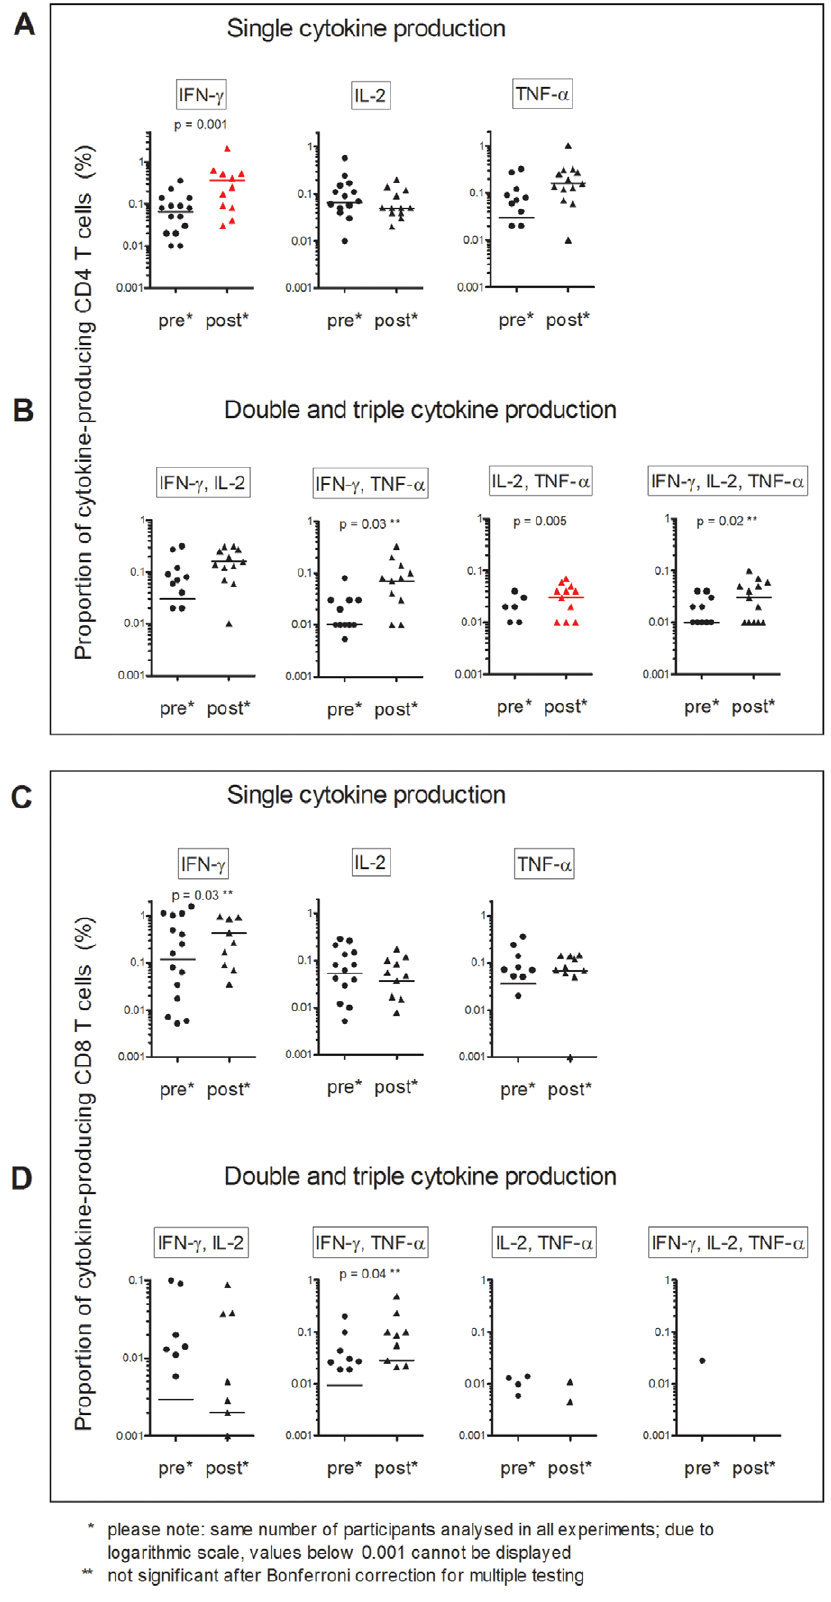
Figure 3. Proportion of cytokine-producing T cells in adults before (pre, n=16) and 10 weeks after (post, n=13) BCG immunisation. Panels A to D as for Figure 2.